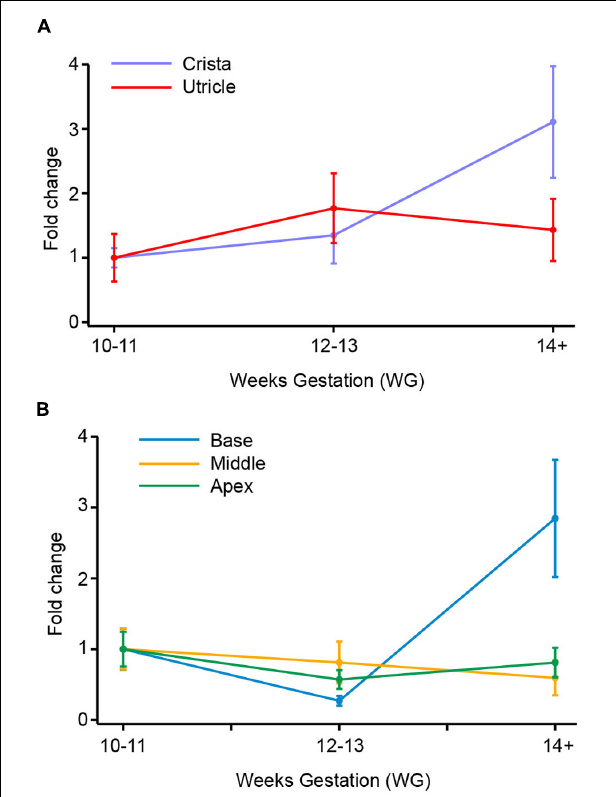
FIGURE 1 | SCN5A (Nav1.5) mRNA in vestibular organs and cochlea. (A) In utricle there is no difference in the expression of SCN5A across the three age groups. In crista, there is a threefold increase in SCN5A from 10–11 WG to 14+ WG. (B) In cochlea there is a 2.8-fold increase in expression of SCN5A mRNA between 10–11 WG and 14+ WG. There were no changes in expression of SCN5A in middle or apex of